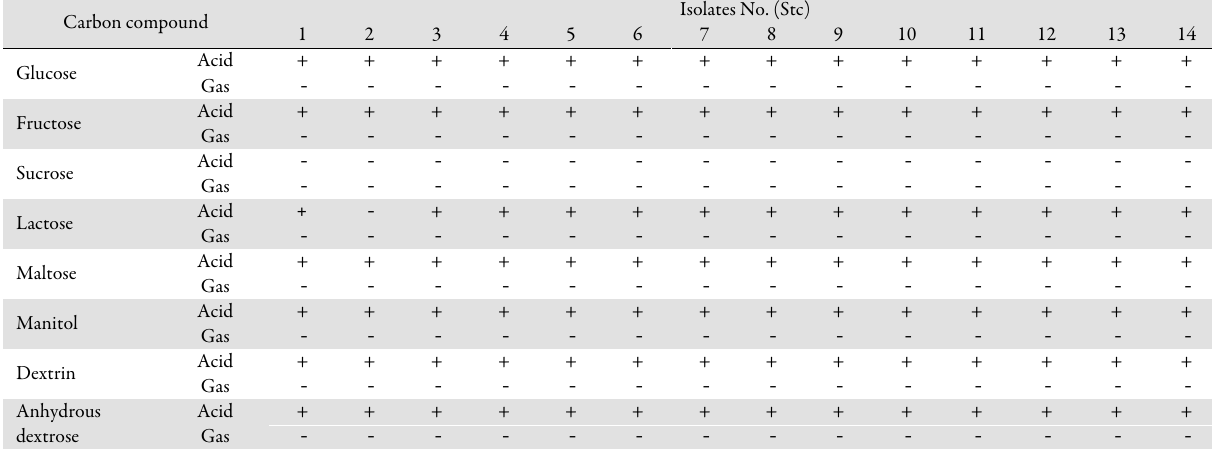
Isolates No. (Stc)